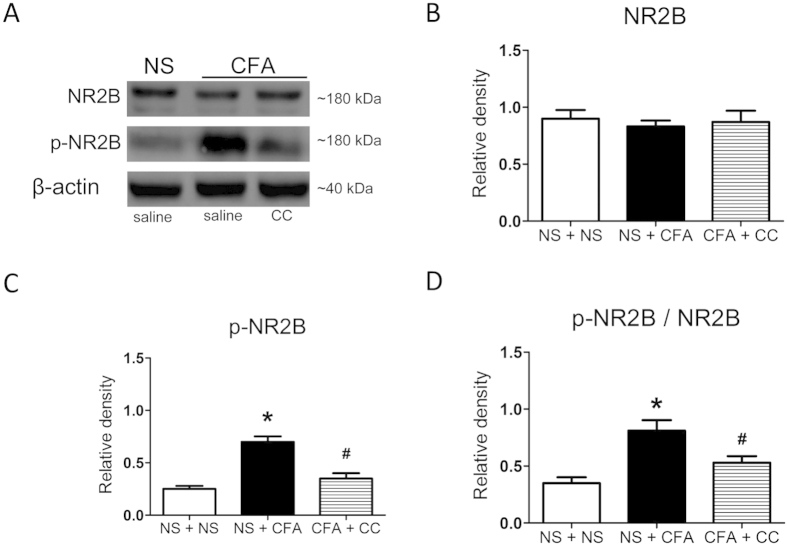
Inhibition of PKC signalling by chelerythrine (CC) decreases the expression of p-NR2B (Tyr1472) in the ARC.(A) Representative immunoblots of ARC against anti-p-NR2B (Tyr1472) and anti-NR2B antibodies from NS- and CFA-injected rats (n = 3 for each group). All experiments were repeated at least twice. (B) The relative level of total-NR2B proteins was unaltered after CFA injection. Similarly, CC treatment did not have any significant effect on total NR2B expression (p > 0.05, n = 3 for each group). All experiments were repeated at least twice. (C) The level of p-NR2B (Tyr1472) was significantly higher in the CFA group than in the NS group. CC treatment markedly suppressed the expression of p-NR2B (Tyr1472) in CFA group as compared with the NS group. (D) The ratio of p-NR2B/NR2B was higher in the CFA group as compared with the NS-injected rats. CC treatment significantly reduced the ratio. *p < 0.05 vs. NS + NS; #p < 0.05 vs. CFA + NS, n = 3 for each group. All experiments were repeated at least twice.